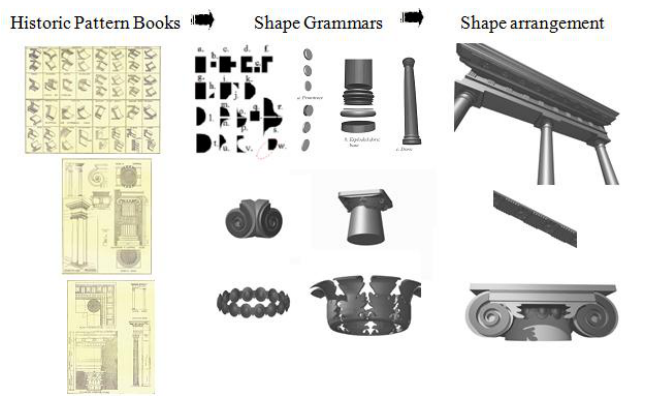
Figure 1. Historic data and shape grammars for classical